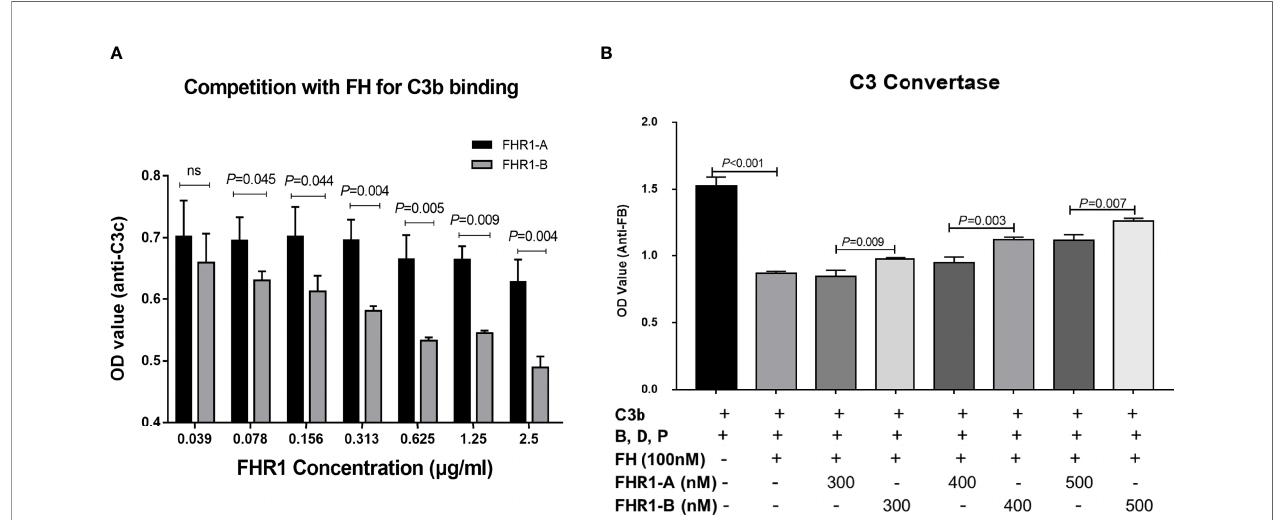
FIGURE 4 | Competition assays of FHR1 with FH to C3b and C3b convertase assays. FHR1*A and FHR1*B compete with FH for binding C3b in a dose-dependent manner, and FHR1*B binds more C3b than FHR1*A at concentrations of 0.078 m g/ml-2.5 m g/ml (A) . FH inhibited the C3bBb assembling, while both isoforms of FHR1 competed with FH and reverse the inhibition to some extent. Moreover, FHR1*B showed a more powerful deregulation effect on FH mediated regulation of the solid-phase C3 convertase (B) . The results are representative of three independent experiments. The data are presented as the means ±